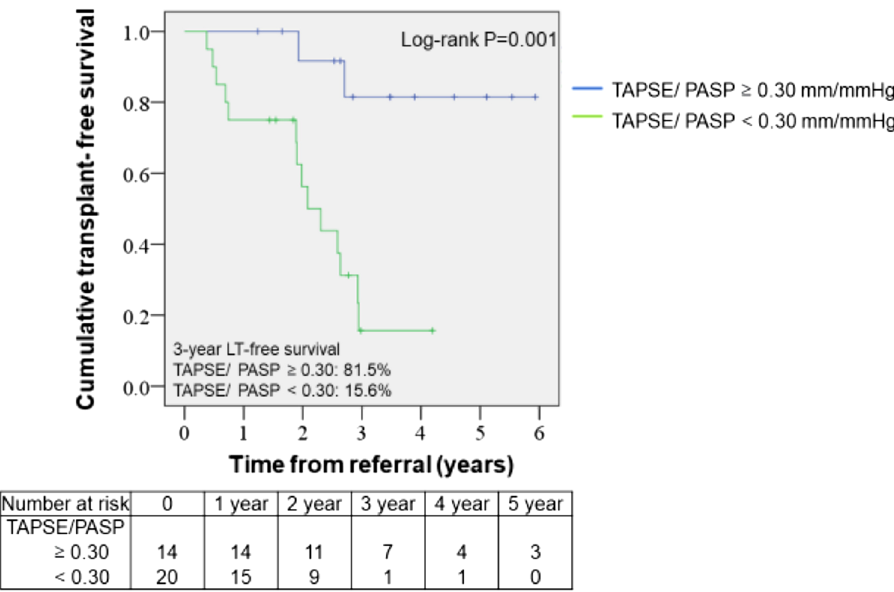
Figure 3. Kaplan–Meyer analysis for freedom from death or LT after referral for LT. PAH patients are stratified according to TAPSE/PASP level at the referral time into two groups (TAPSE/PASP ≧ 0.30, n = 14; TAPSE/ PASP < 0.30, n = 20). LT lung transplantation, PAH pulmonary arterial hypertension, PASP pulmonary arterial systolic pressure, TAPSE tricuspid annular plane systolic